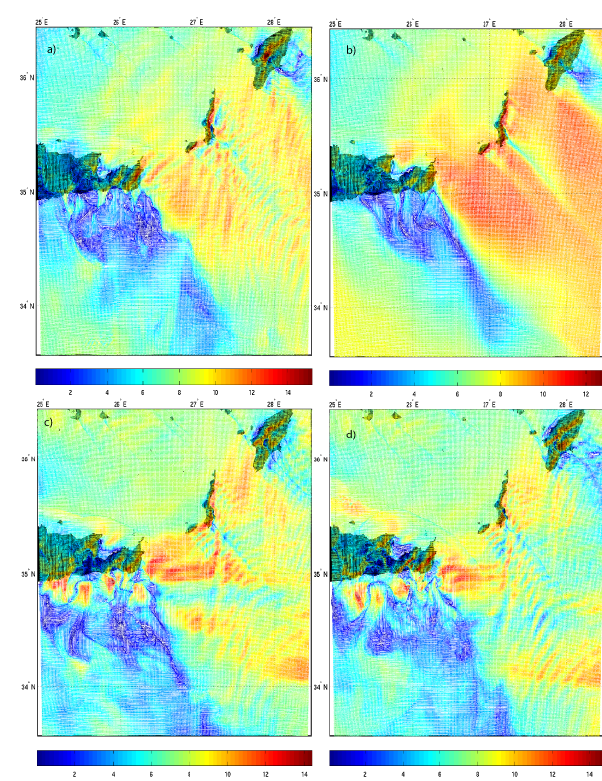
Figure 2. 10m wind speed (colors) simulated by the WRF model (inner domain) in the CTL run ( a , left top), the DIFF run ( b , right top), the SMG run ( c , left bottom), and the MYJ run ( d , right bot- tom) at 08:00UTC, 15 May 2008. The dark regions correspond to the island location. The maps cover the area delimited with the black border in Fig. 3. Section 4 explains the characteristics of the di ff erent experiments.